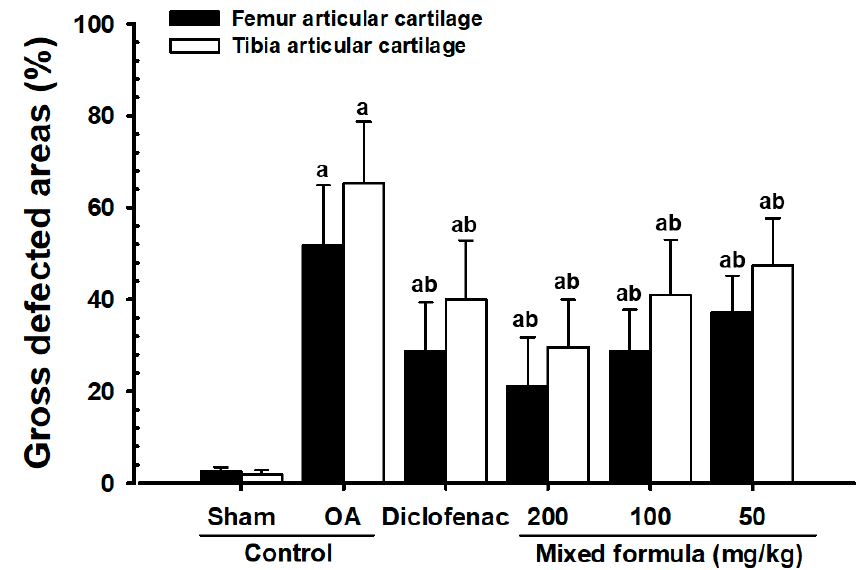
Figure 6. Changes on the femur and tibia articular cartilage defect areas in sham-operated or OA rabbits. Values are expressed mean ± S.D. of eight rabbits, %. OA = Osteoarthritis; AR = Aqueous extracts of Achyranthis Radix; EC = Aqueous extracts of Eucommiae Cortex; PCP = Dried Pomegranate Juice Concentrated Powder. a p < 0.01 as compared with sham control; b p < 0.01 and c p < 0.05 as compared with OA control.